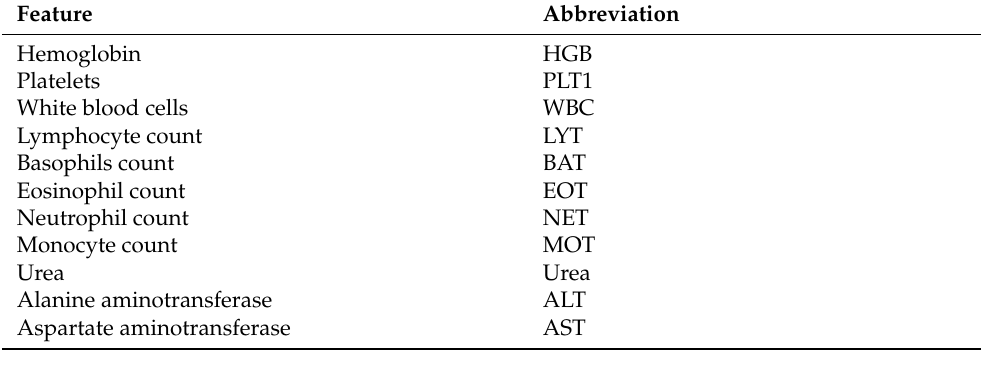
Table 3. The used features in Dataset 2.